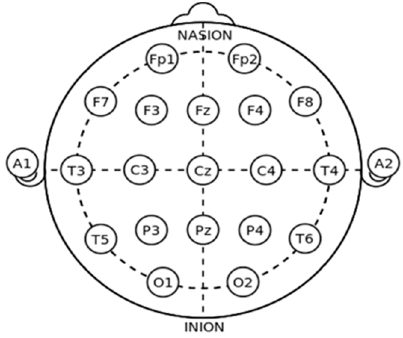
Figure 1. The international 10–20 system [114]. Figure 1. International 10–20 system